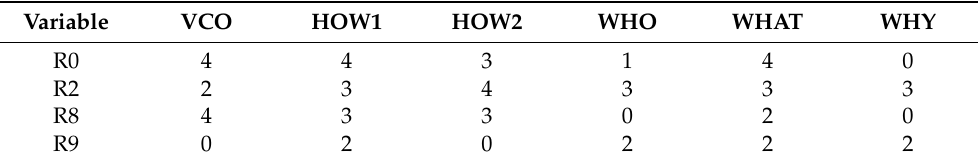
Table 7. Transformed Pearson’s partial correlations ( r t * ) among BM elements and CE strategies of CR COMPANIES (conditioned on variable: CONSORTIUM) (transformed from values in the Table 5). Variable VCO HOW1 HOW2 WHO WHAT WHY